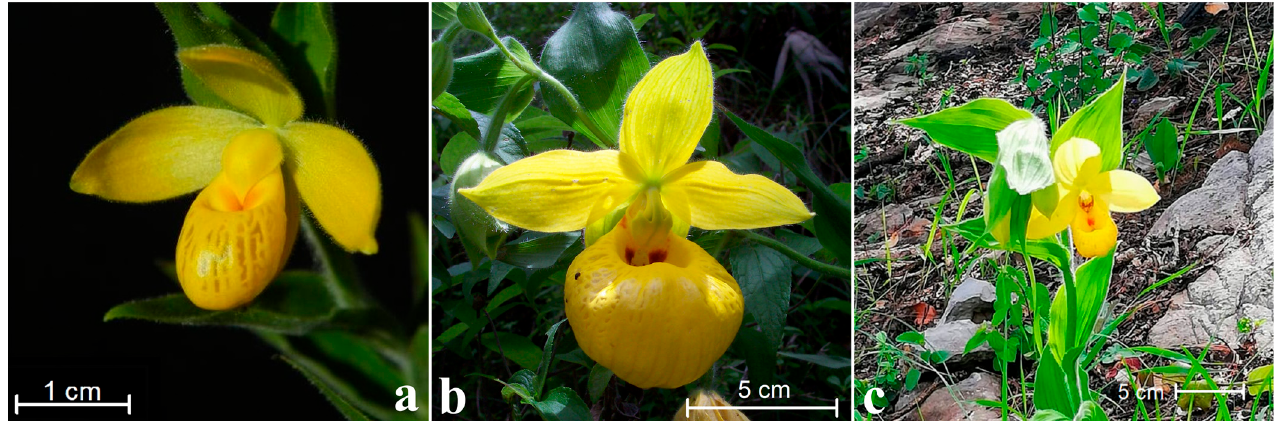
Figure 1. Mesoamerican Cypripedium : ( a ) C. dickinsonianum , ( b ) C. irapeanum and ( c ) C. molle , pictures taken by Javier Fortanelli, Mauricio Moreno, and Octavio Gabriel in the years 2014, 2010 and 2019, respectively.